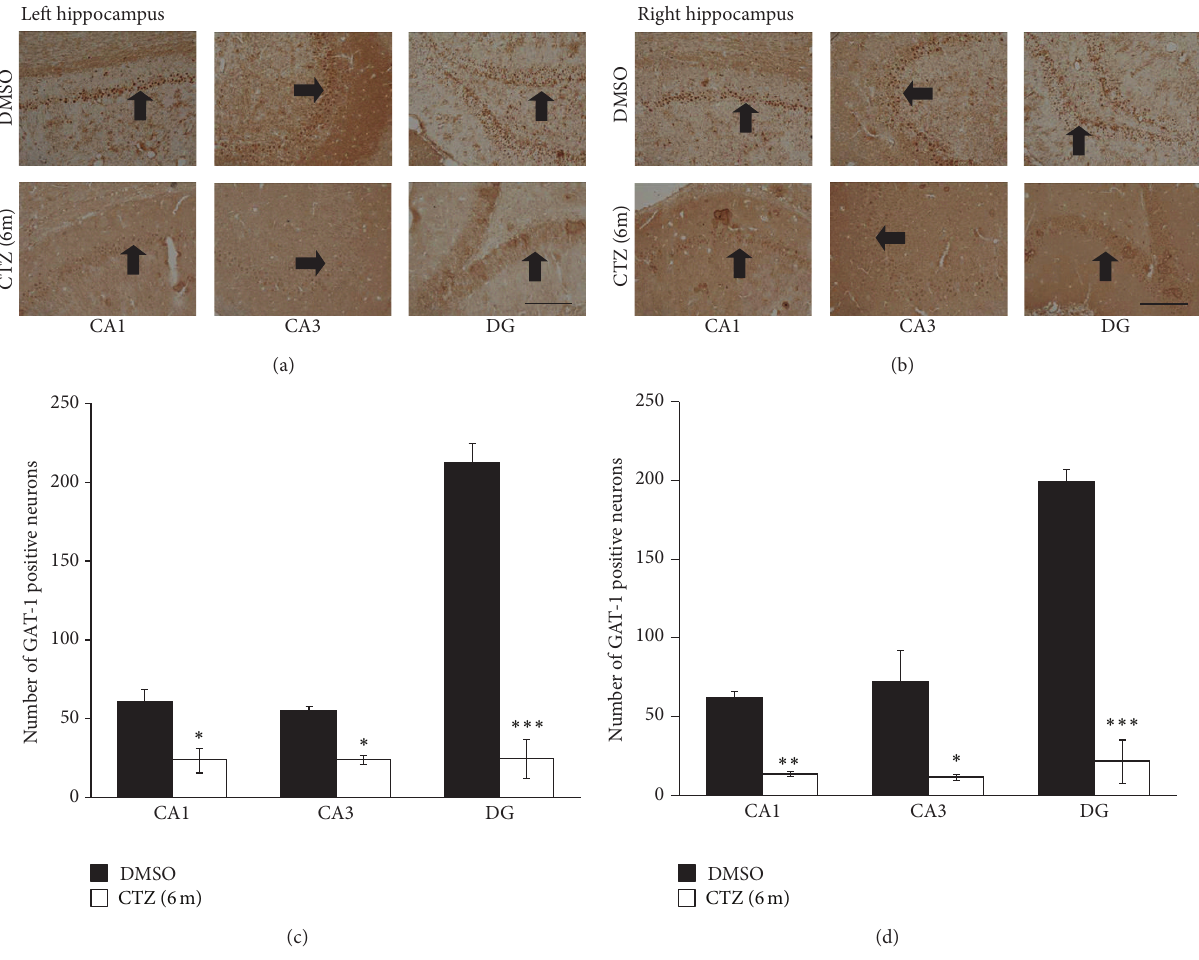
Figure5:DecreasedGAT-1staininginhippocampusofrecurrentseizurerats6monthsafterseizureinductionbyCTZ.(a-b)Picturesshowing GAT-1 positive cells (arrow indicated) in left (a) and right (b) hippocampus from rats 6 months after either DMSO (top) or CTZ (bottom) treatment. (c-d) Group data showing significant decreases of the GAT-1 staining cells in CA1, CA3, and DG area of the hippocampus from rats 6 months after either DMSO ( 𝑛 = 3 ) or CTZ ( 𝑛 = 3 ) treatment. ∗ 𝑃 < 0.05 , ∗∗ 𝑃 < 0.01 , and ∗∗∗ 𝑃 < 0.001 compared to the DMSO control group. Scale bar in (a) and (b): 200 𝜇